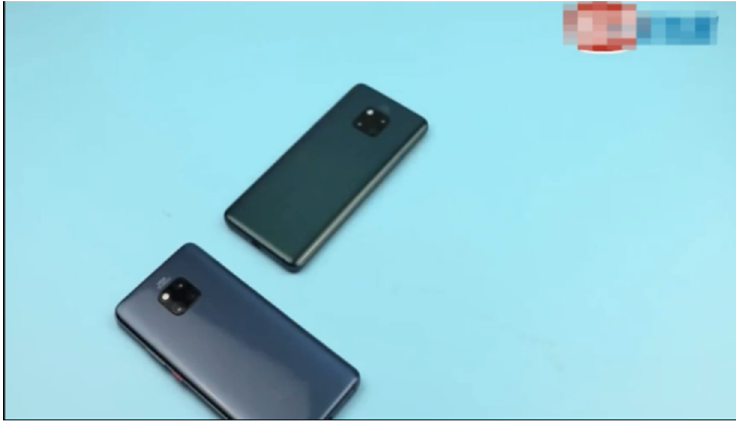
Figure 4. Example of information presented in the no usage scenario.